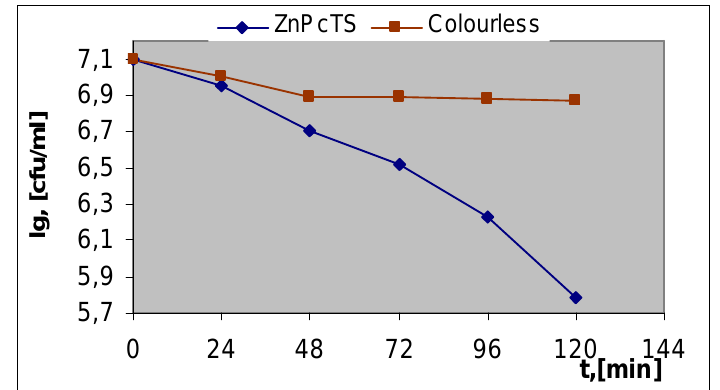
FIGURE 7. Kinetics of photodisinfection of a microbial solution with the ZnPcTS